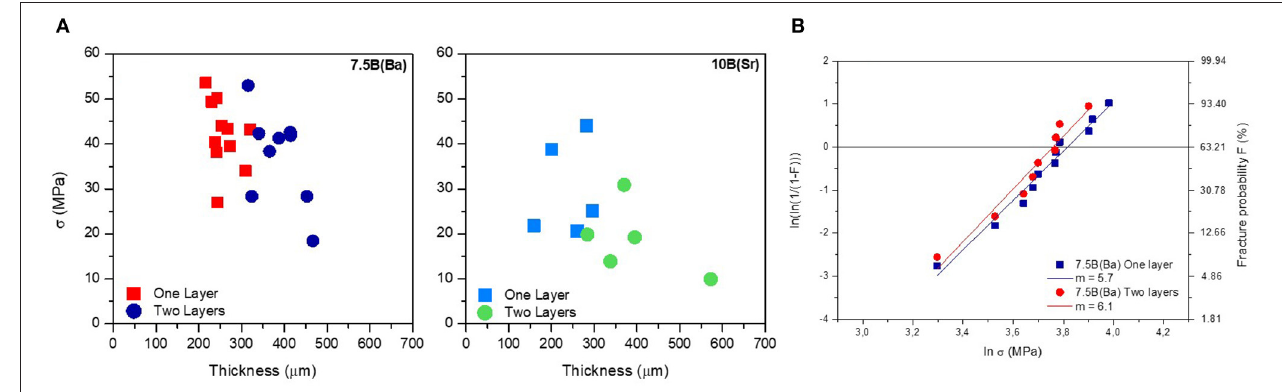
FIGURE 9 | (A) Influence of the seal thickness on the flexural resistance values, left composition 7.5B(Ba), right composition 10B(Sr). (B) Weibull distribution for bars joined with one or two layers of glass-ceramic